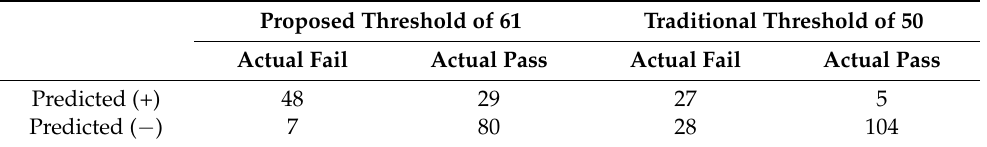
Table 2. The model performance table. Proposed Threshold of 61 Traditional Threshold of 50 Actual Fail Actual Pass Actual Fail